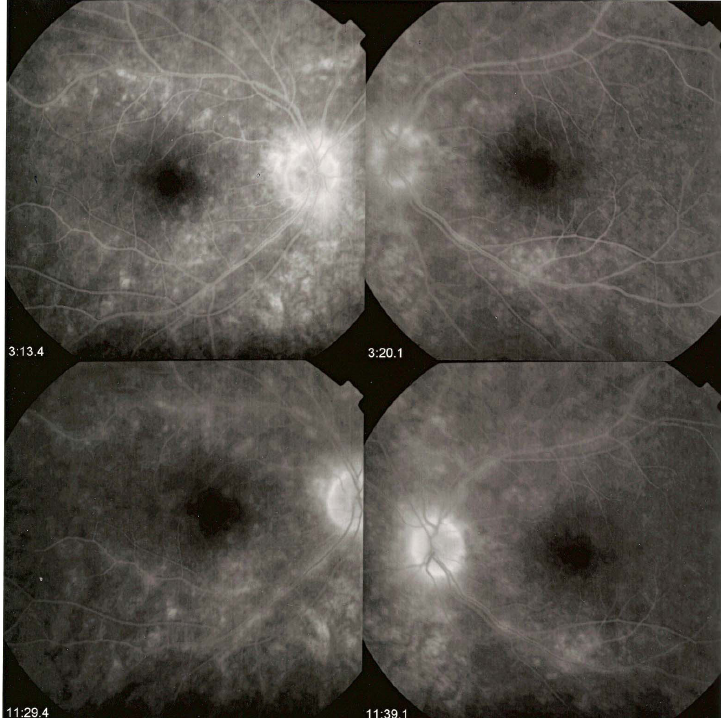
Figure 4. FA in HLA-A29 birdshot retinochoroiditis. Disc hyperfluorescence, retinal vasculitis, diffuse posterior pole oedema with relative sparing of the central macula.